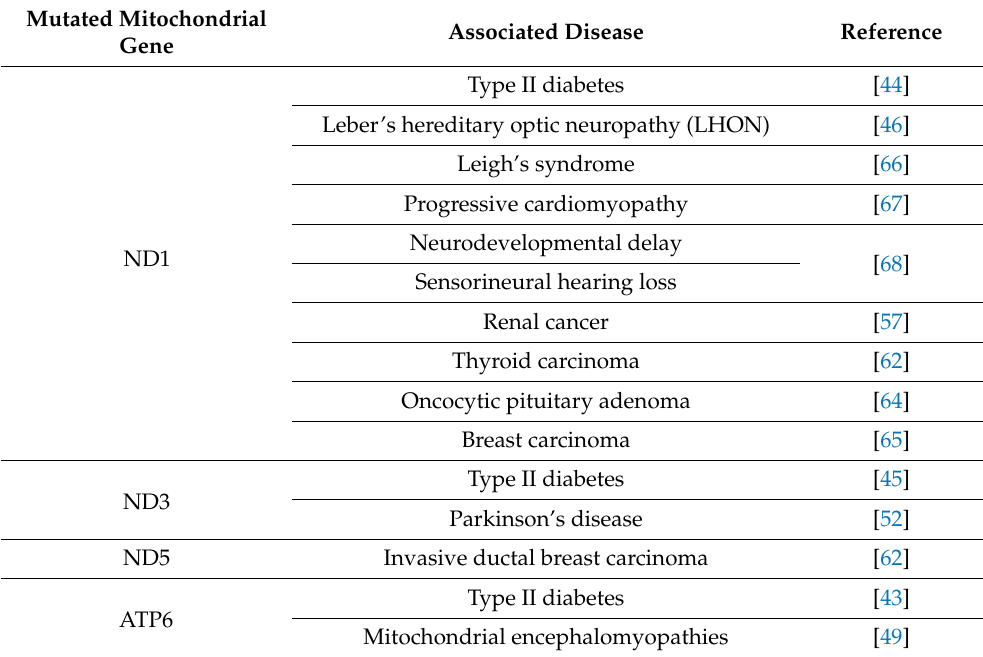
Figure 2. Illustration of the mitochondrial genome with a focus on the mitochondrial genes that suffer the greatest number of mutations (ND1, ND3, and ATP6) and the organs/tissues affected by these mutations and their associated diseases. Image created at BioRender.com. Table 1. Summary of mitochondrial genes affected by mutations and the associated diseases.